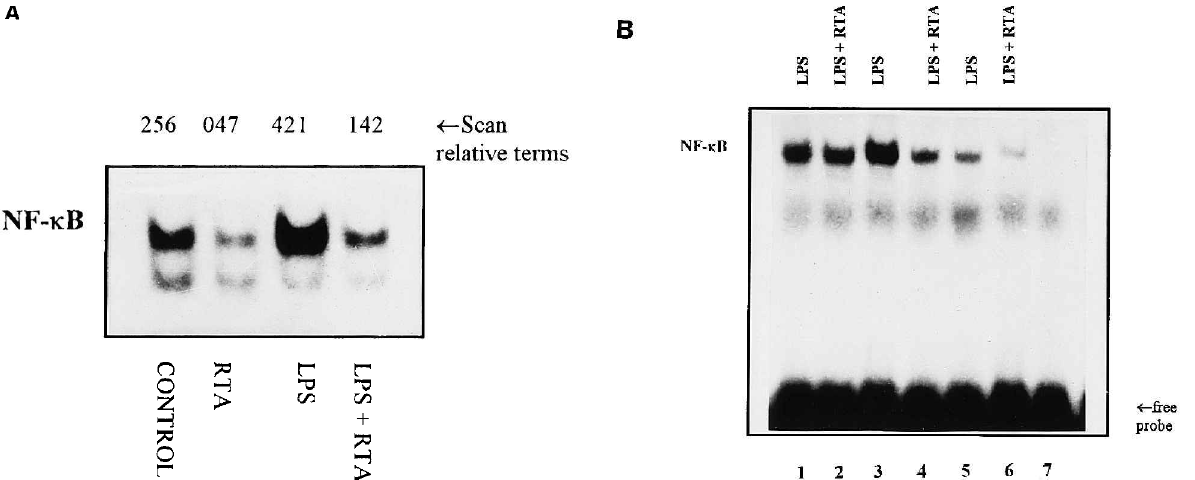
FIG. 5. (A and B) Inhibition by RTA of NF- k B binding to DNA sequences. Electrophoretic mobility shift assay of nuclear extracts isolated from (A) control, RTA- (10 m M), LPS- (500ng/ml) or RTA + LPS-treated U937 cells primed with PMA; (B) LPS- (500ng/ml) or LPS+RTA (10 m M)- treated U937 cells primed with PMA. Cells were incubated for 1h with RTA, followed by LPS addition (A) for 30min or (B) for 15min, lanes 1,2; 45min, lanes 3,4; and 90min, lanes 5,6. In lane 7 competitor (unlabelled oligo DNA) was run. The nuclear extracts were isolated and processed as described in Materials and Methods. Densitometric scans (A) are expressed in arbitrary units.